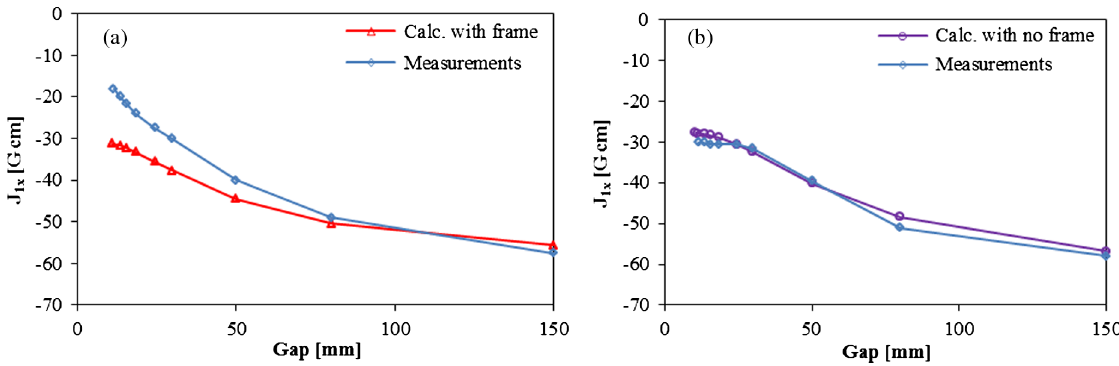
FIG. 12. Transverse horizontal filed integrals obtained from simulations and measurements along the median plane of an ID: (a) APS27 #5s with magnetic frame; (b) UNA33